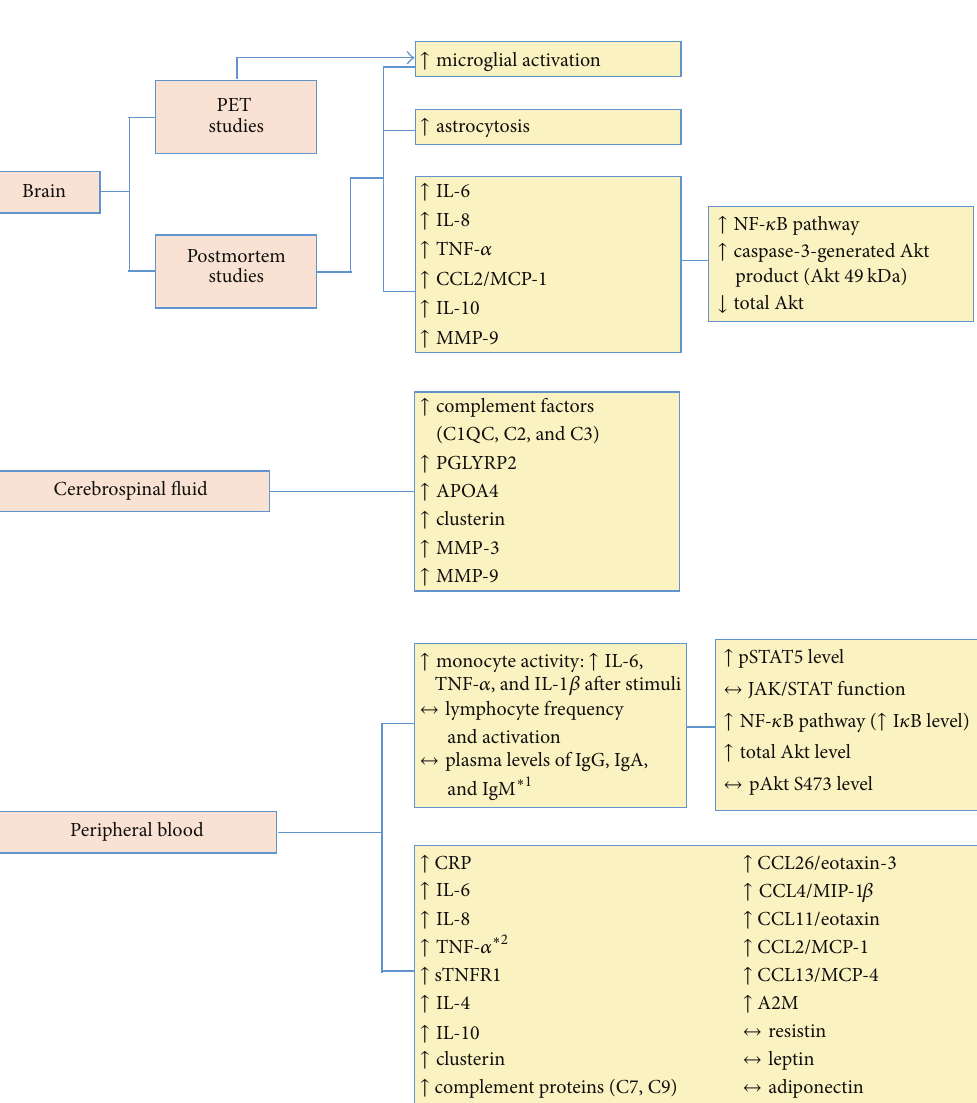
Figure 1: Inflammatory/immune changes observed in patients with Huntington’s disease. Postmortem studies have shown increased microglia activation and astrocytosis in brain from patients who suffered from HD. In addition, increased expression of inflammatory mediators, such as cytokines and proteins related to intracellular pathways, was found in brains from patients with HD. Studies using PET also demonstrated increased microglial activation in HD. Cerebrospinal fluid samples from patients with HD presented increased levels of inflammatory mediators. In addition to changes in the central nervous system, patients with HD also display increased peripheral levels of inflammatory mediators, such as cytokines, chemokines, and complement factor proteins, besides alteration in monocyte activity and intracellular signaling proteins. A2M = alpha-2-macroglobulin; Akt = protein kinase B; APOA4 = apolipoprotein A4; CRP = C-reactive protein; HD = Huntington’s disease; Ig = immunoglobulin; IL = interleukin; JAK/STAT = janus kinase/signal transducer and activator of transcription; MCP = monocyte chemoattractant protein; MIP = macrophage inflammatory protein; MMP = matrix metalloproteinase; NF- 𝜅 B = nuclear factor kappa; PET = positron emission tomography; PGLYRP2 = peptidoglycan recognition protein 2; sTNFR1 = soluble